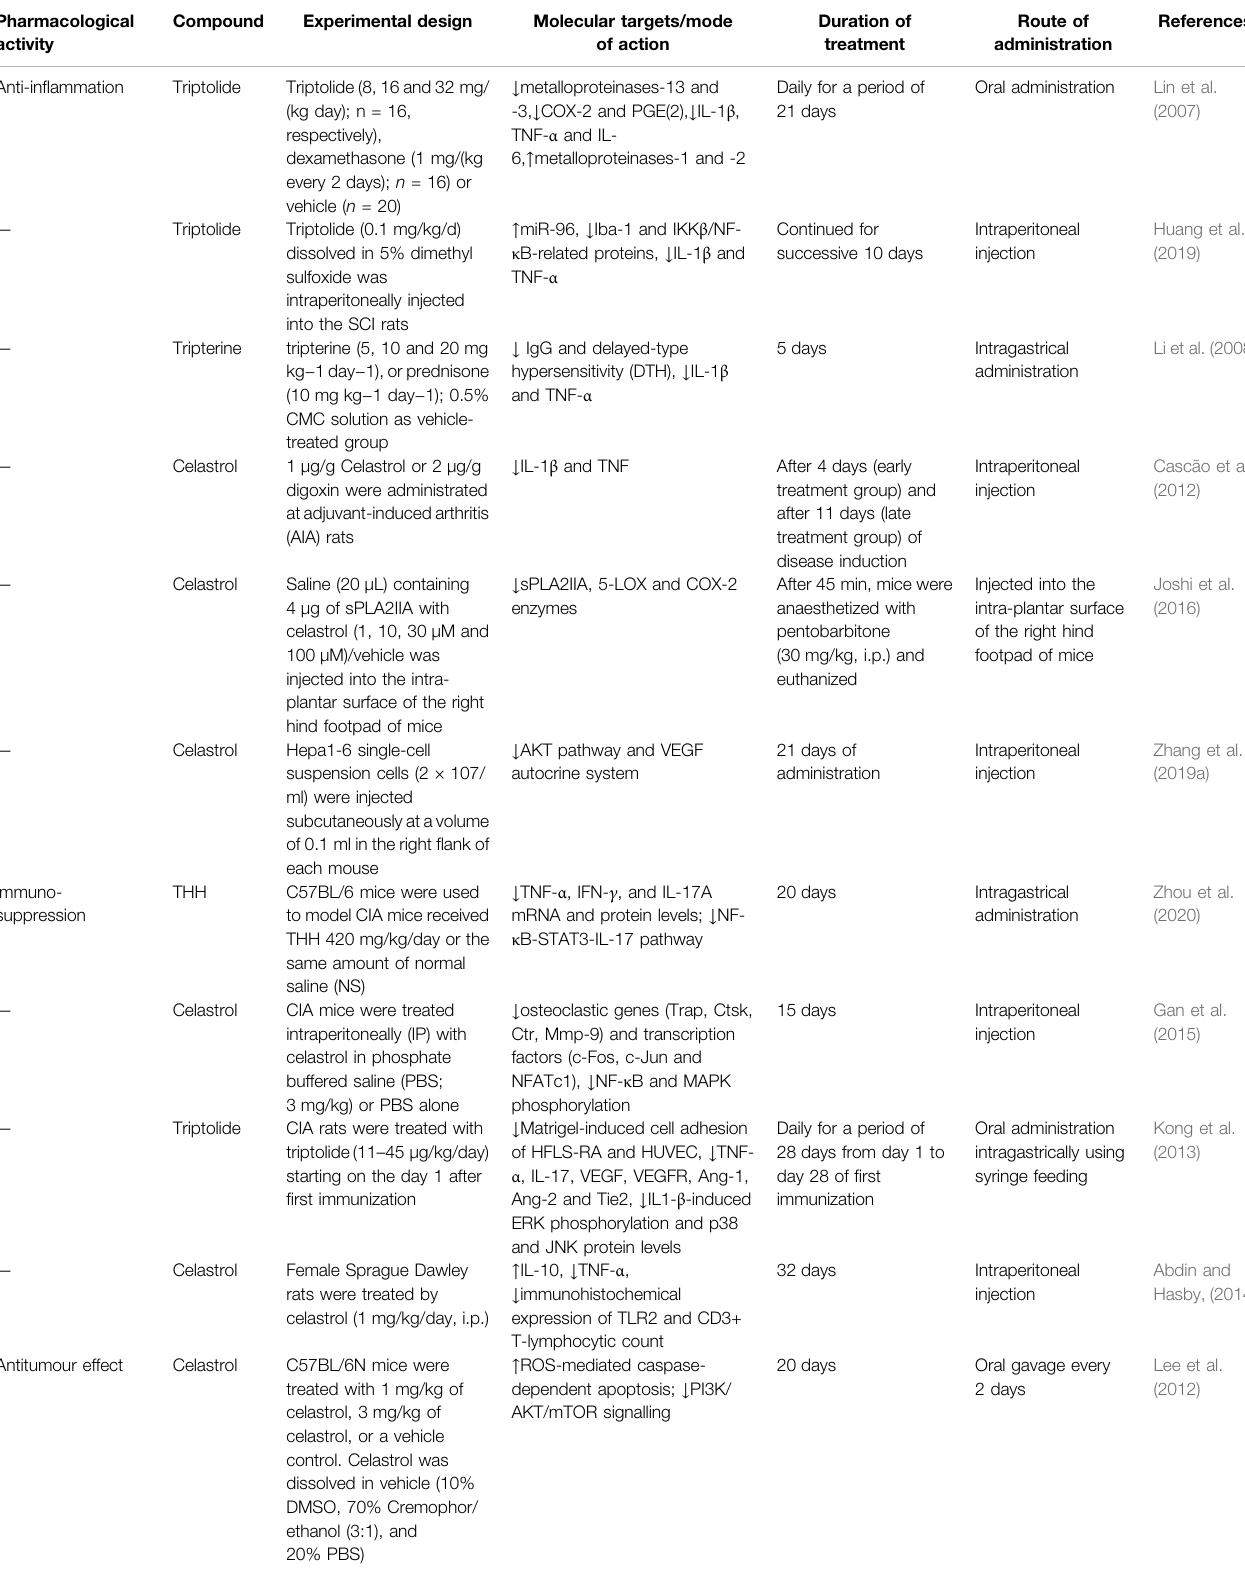
TABLE 5 | Pharmacological effects of different compounds isolated from Tripterygium hypoglaucum in vivo